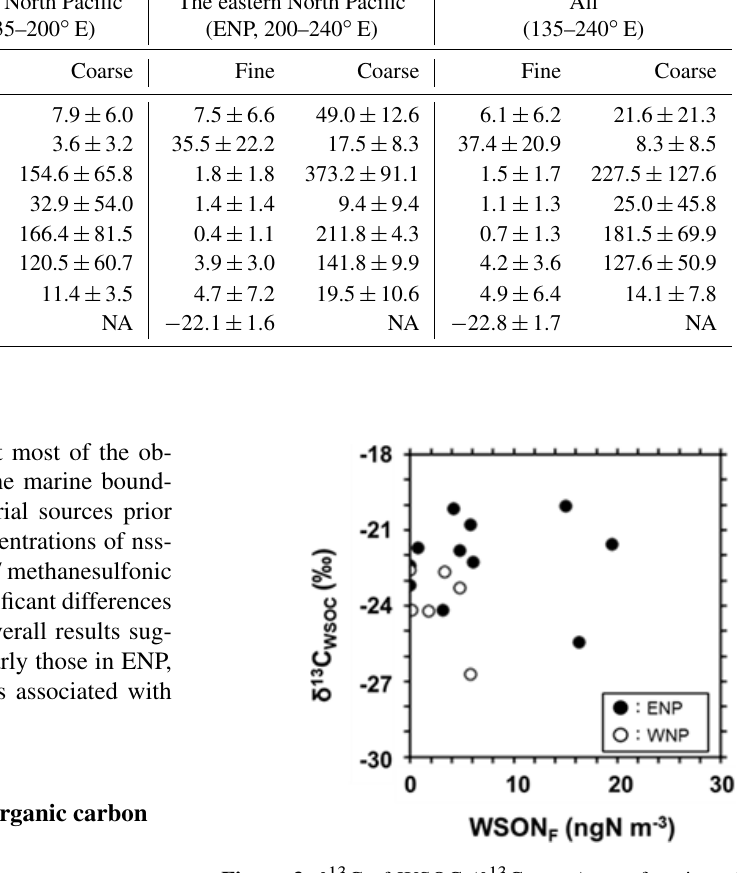
Figure 3. δ 13 C of WSOC ( δ 13 C WSOC ) as a function of the con- centrations of WSON F . Solid and open circles indicate the data of the eastern North Pacific (ENP; 200–240 ◦ E) and the western North Pacific (WNP; 135–200 ◦ E),